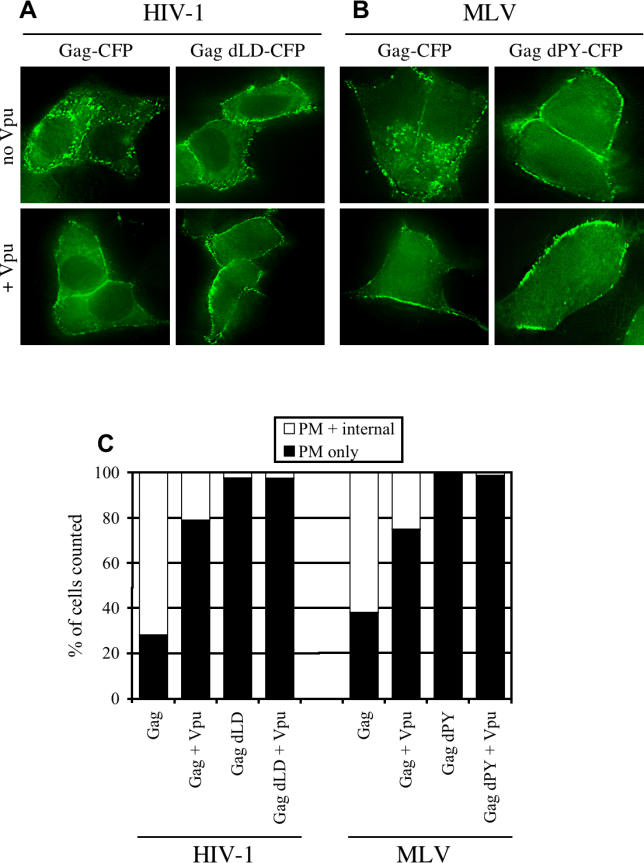
Endosomal Accumulation of HIV-1 and MLV Gag-CFP Requires a Functional L-DomainHeLa cells were transfected with plasmids expressing HIV-1 (A) or MLV Gag-CFP (B), or mutant variants thereof lacking functional L-domains (HIV-1 Gag dLD-CFP and MLV Gag dPY-CFP, respectively) in the presence or absence of co-expressed Vpu, as indicated. The cells were fixed at 18 h post-transfection and images acquired. Representative examples are shown in panels (A) and (B) and a quantitative assessment of Gag-CFP localization, enumerated as in Figure 1, is shown (C). The numbers of HIV-1 Gag-CFP–expressing cells in ten fields exhibiting Gag-CFP accumulation only at the PM (black bars) or at intracellular sites (white bars) were counted, as in Figure 2C, and are plotted as a percentage of the total number of cells with Gag-CFP accumulations.